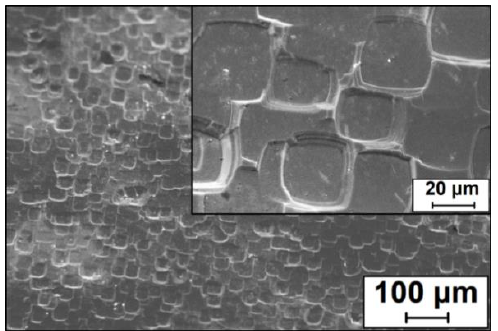
Figure 1. SEM image of the unpolished side of a Si wafer showing regularly distributed square indents; inset shows a higher magnification SEM image. inset shows a higher magnification SEM